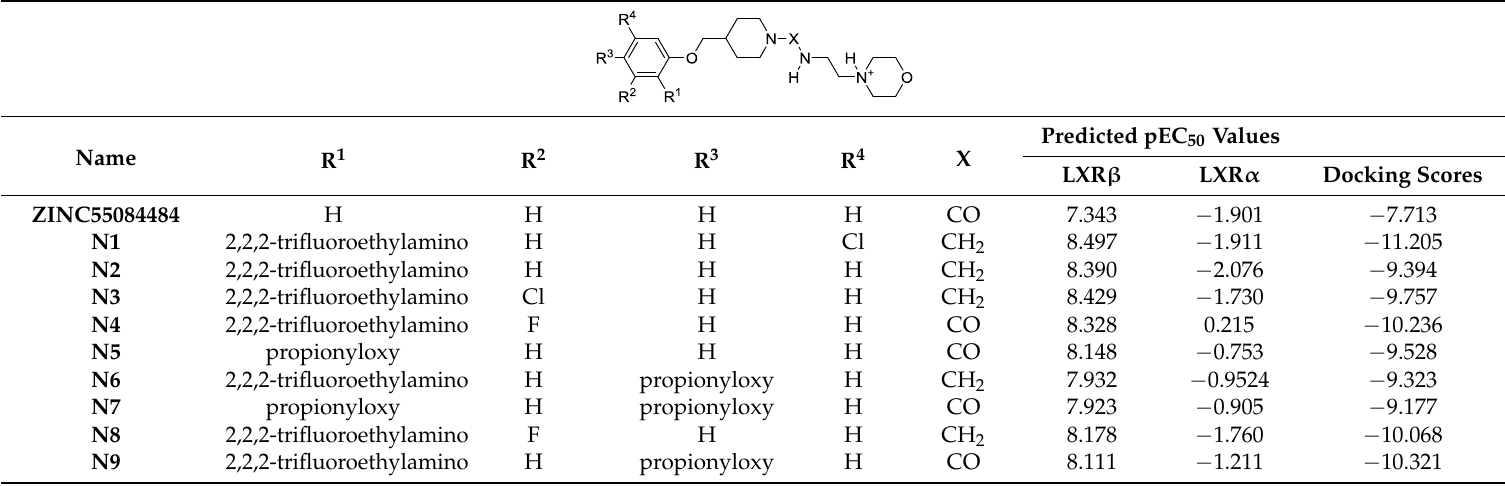
Table 6. Chemical structures of newly designed LXRβ-selective agonists based on two QSAR Models.